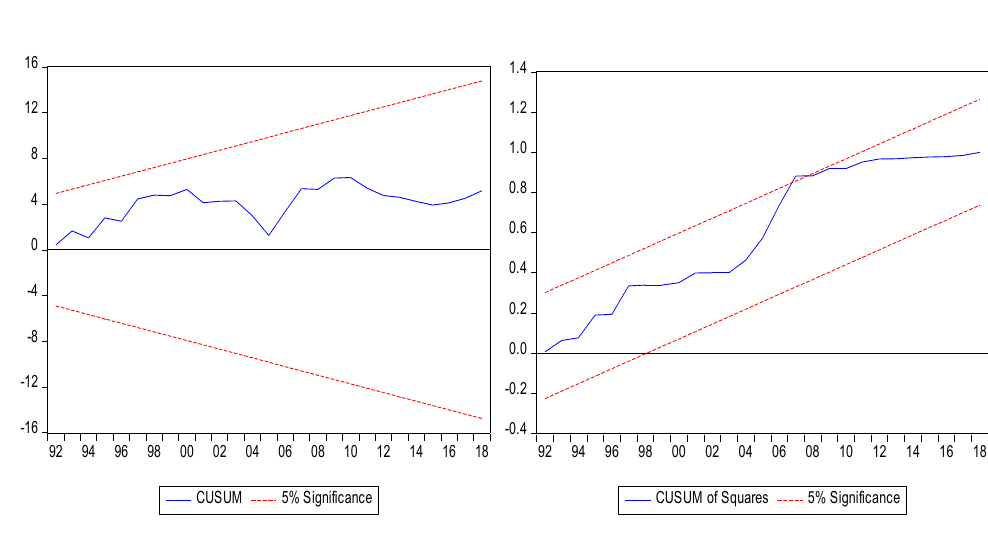
Fig. 7. CUSUM test. Fig. 8. CUSUM of squares